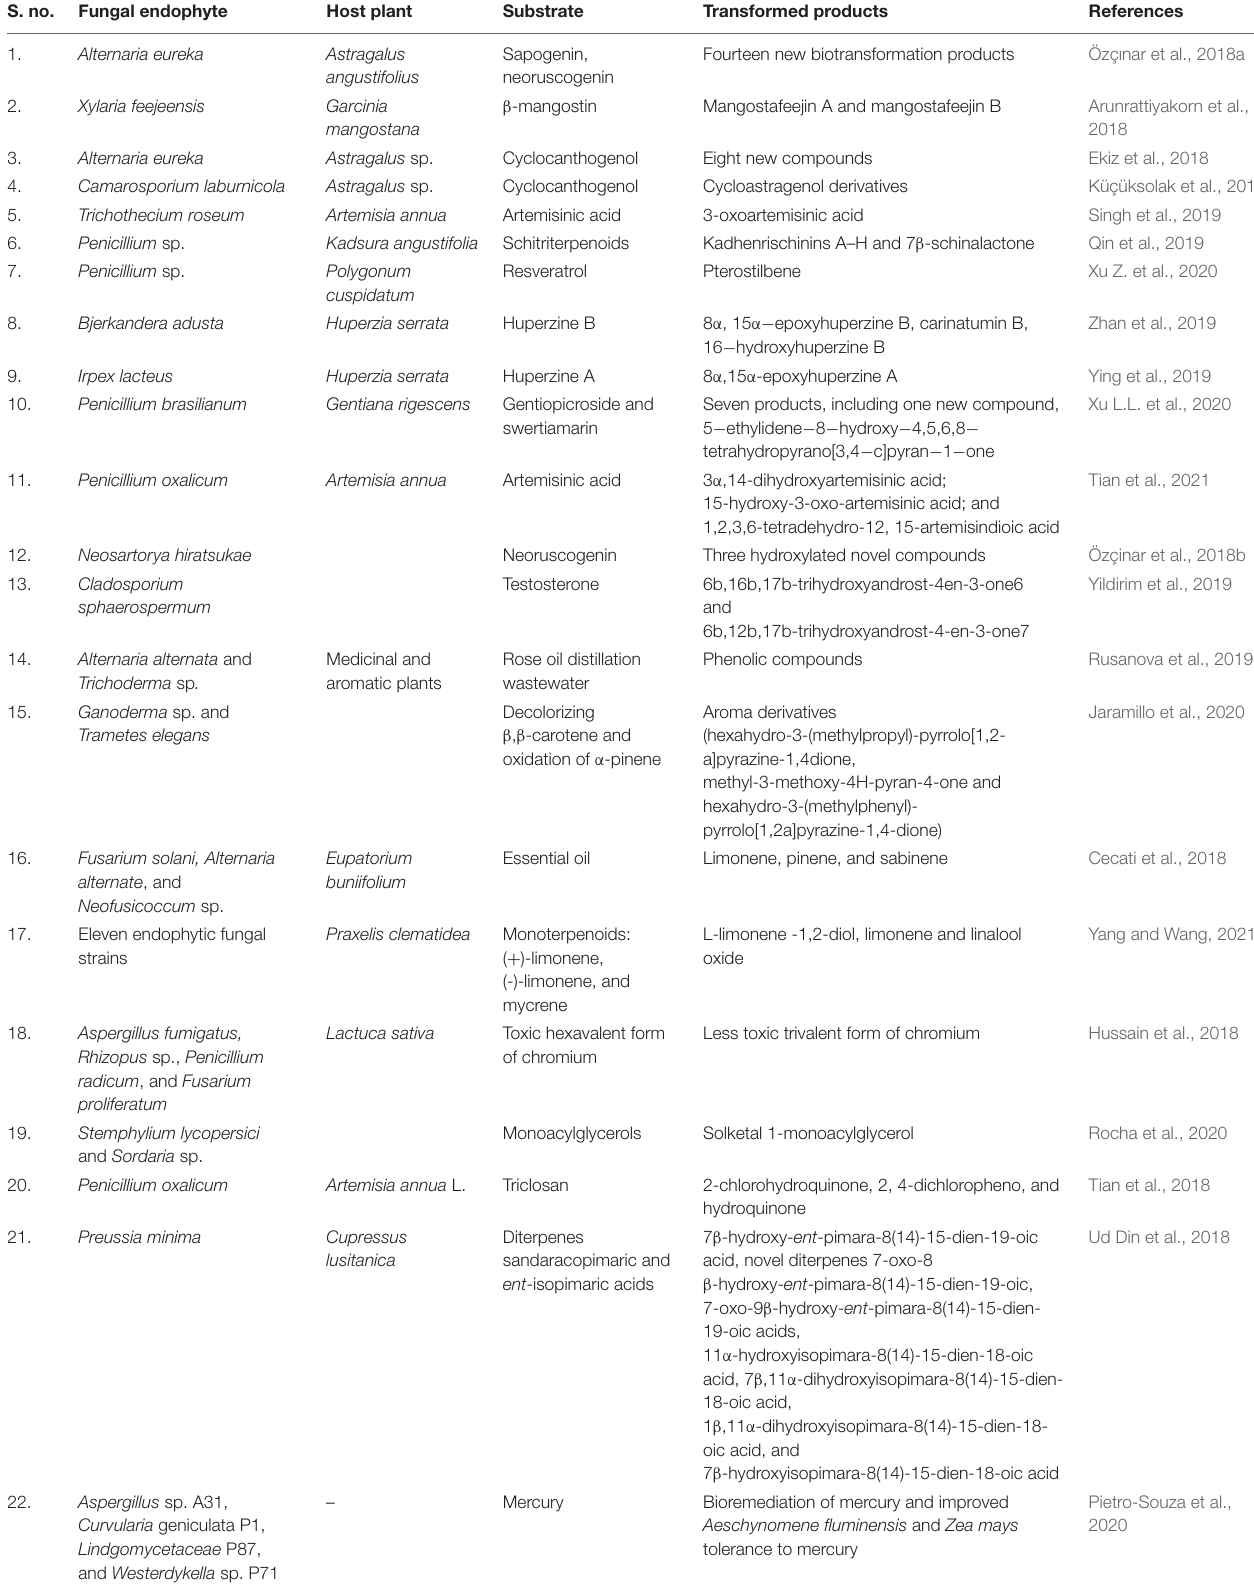
TABLE 1 | Summary of recent biotransformation reactions mediated by endophytic fungi. S. no. Fungal